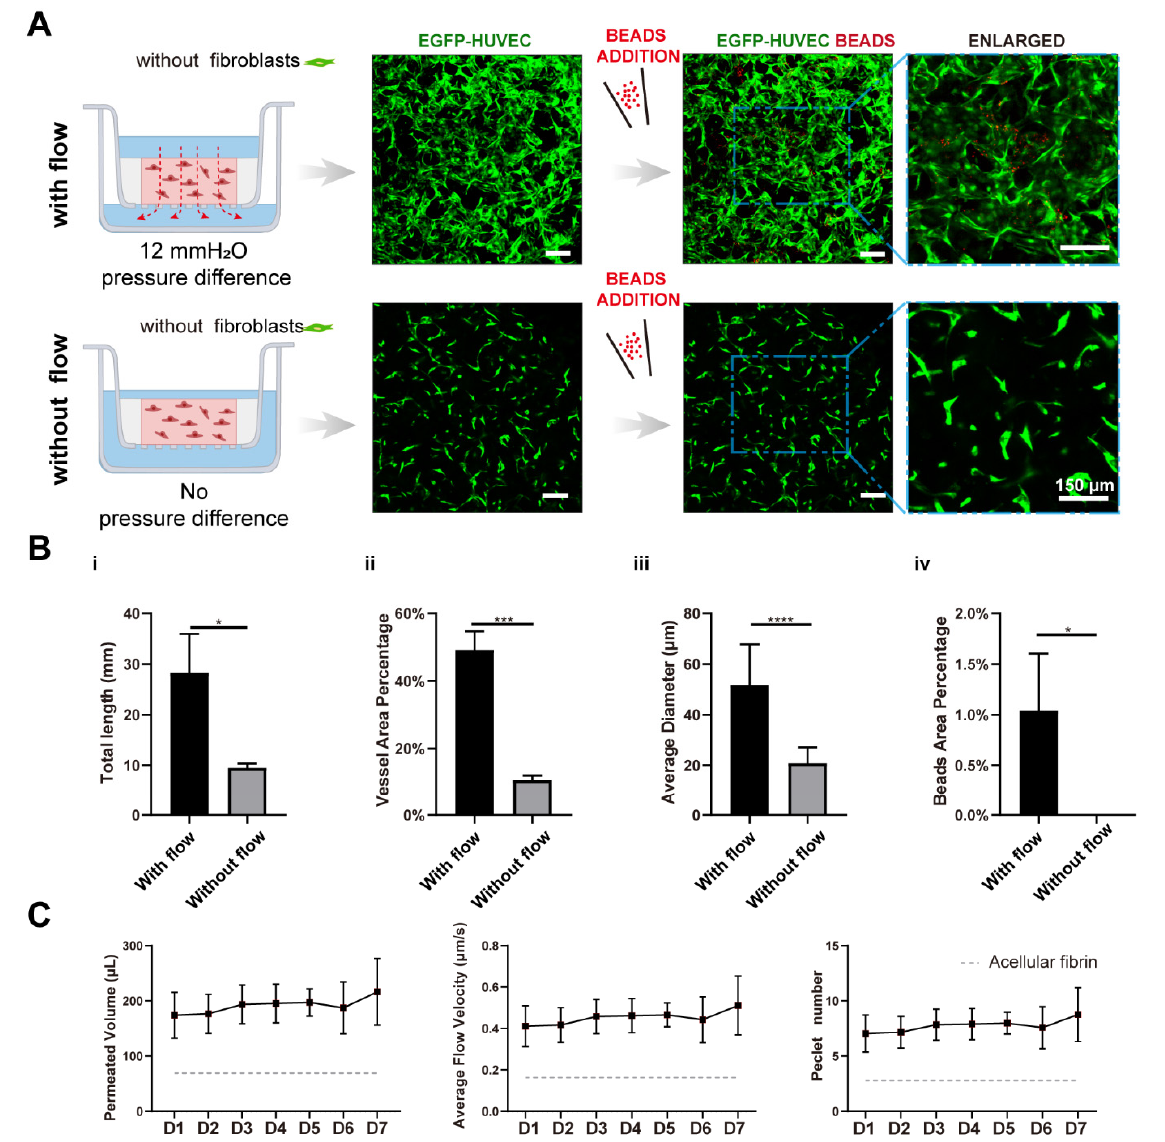
Figure 5. Interstitial flow alone promoted vascular perfusability and morphogenesis in the absence of fibroblasts. ( A ) Confocal images of constructed vasculatures in the absence of the NHLFs, and with/without flow. The constructed vessels were perfused with red beads to characterize the perfusability. Scale bar: 150 µ m. ( B ) The analyzed morphological statistics of the vessels, including total length ( i ), vessel area percentage ( ii ), average diameter ( iii ), and the beads area percentage ( iv ) which represented the perfusability of the vasculatures. The data was presented with the average value ± standard deviation ( n = 3). p -Values were calculated using the student’s t -test. *, p < 0.05; ***, p < 0.001; ****, p < 0.0001. ( C ) The permeated volume, average flow velocity, and P é clet number statistics in the absence of NHLFs over 7-day period, with the gray dash line indicating the acellular fibrin. The data was presented with the average value ± standard deviation ( n =